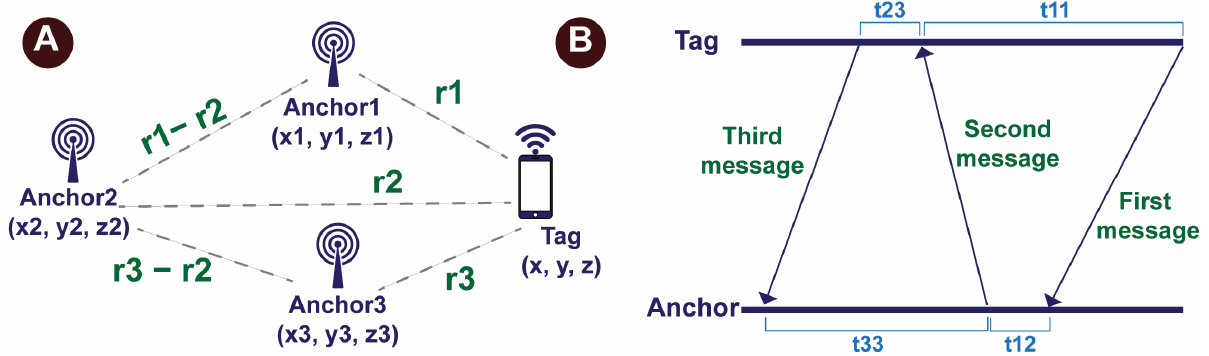
Figure 6. ( A ) TDoA method and ( B ) Round-trip time of arrival method. We can calculate the distance between predefined objects and the user according to the positioning tag and the location of three anchors in an indoor space.